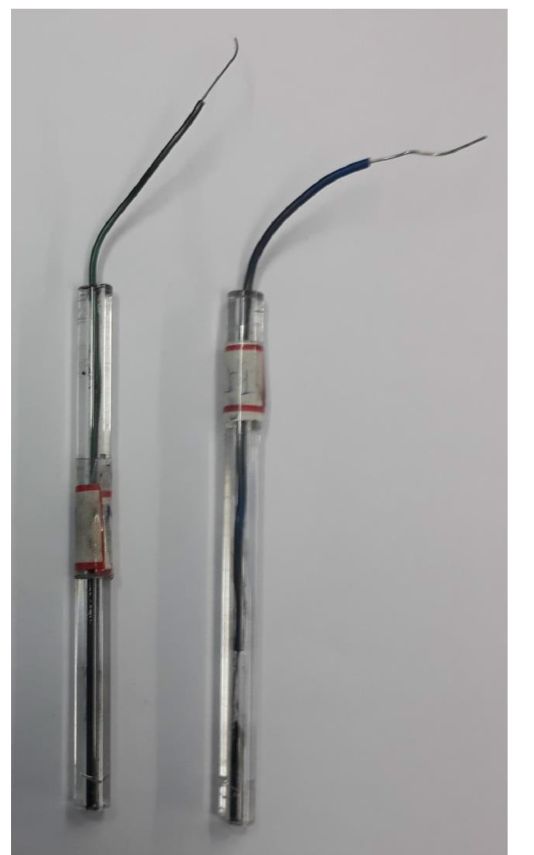
Figure 1. The fabricated electrode, CPs and ZnONPs modified